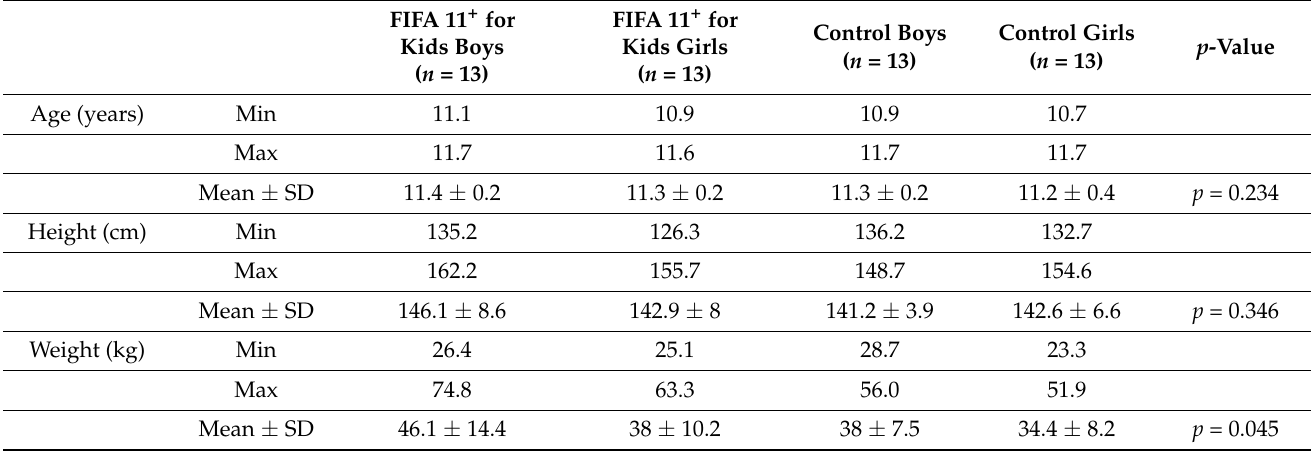
Table 1. Physical characteristics of the